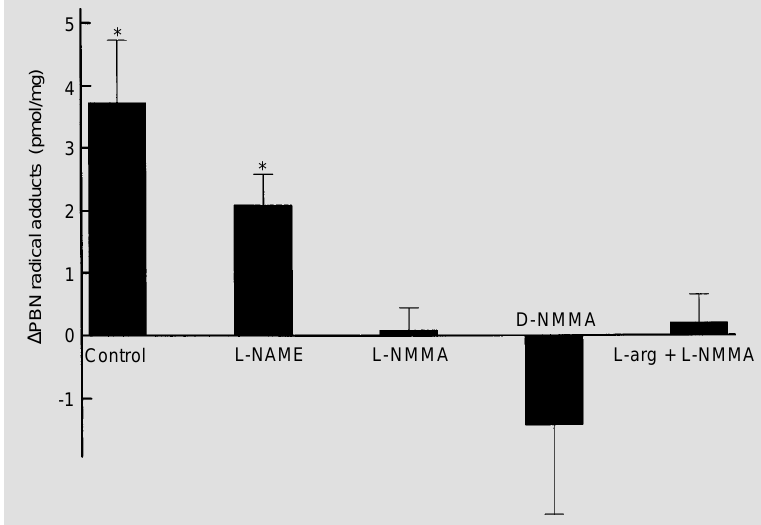
Figure 2 - The effects of several treatments on papaverine-induced increases in flow (open bars) and arterial plasma ascorbyl radical levels (closed bars). A pairwise control papaverine injection was performed in each rabbit before starting the treatments; however, since blood flow and ascorbyl radical changes were similar for all treatment groups for this control condition, the results were pooled for simplification (Control; N = 25). Neither L-NMMA (N = 6) nor D-NMMA (N = 6) altered papaverine-induced flow changes, but they both completely abolished the corresponding ascorbyl radical increase. Excess L-arginine coinfusion with L- NMMA (L-arg + L-NMMA; N = 5) did not overcome the blockade in ascorbyl increase. L- arginine (L-arg; N = 3) alone diminished papaverine-induced flow changes (P<0.05 vs other treatments), but did not impair ascorbyl radical increases. Data with L-NAME were previ- ously published (9) and are shown only for comparison. **P<0.001, and *P<0.05 vs baseline, respectively (ANOVA and Student-Newman-Keuls multiple range test). Data are reported as means ± SEM.